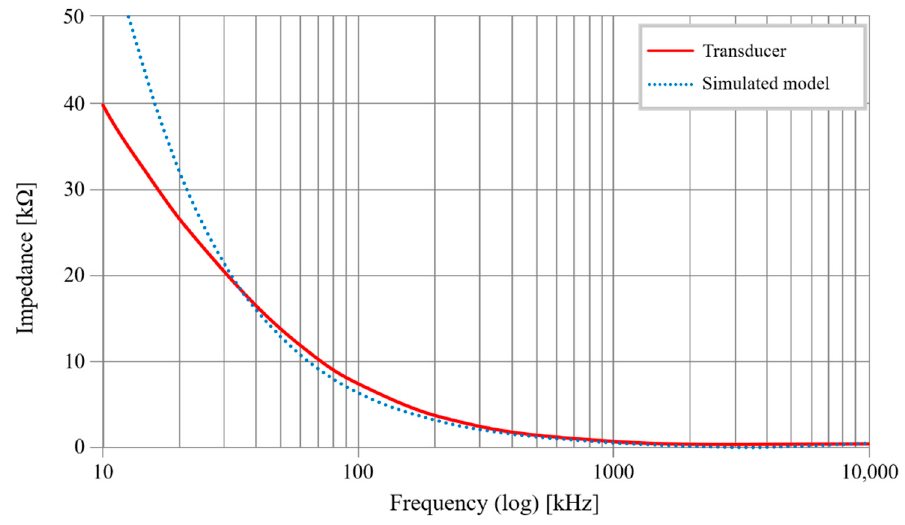
Figure 24. Sensor model: simulated vs. transducer results.